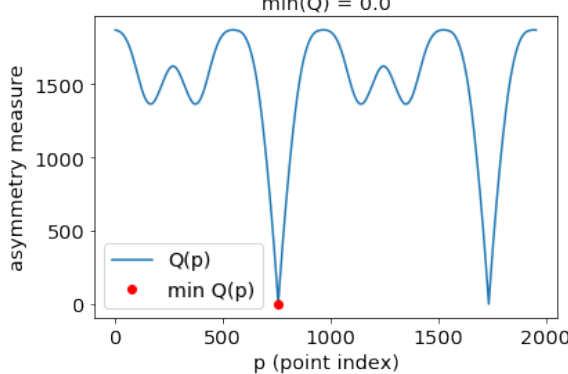
Figure 5. The asymmetry measure of the Σ contour from different contour points.